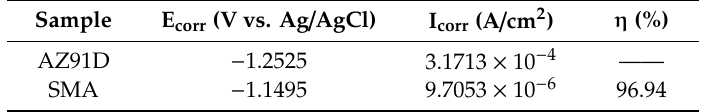
Table 1. Electrochemical dates of the polarization curves obtained from the samples.